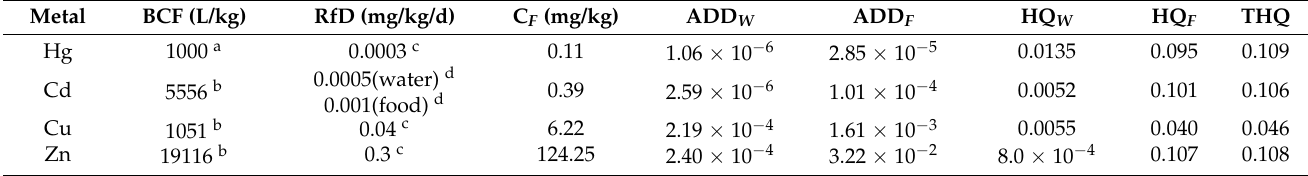
Table 7. Estimated non-carcinogenic hazard quotients (HQs) for Hg, Cd, Cu, and Zn from drinking water and fish consumption by the native residents of Taihu